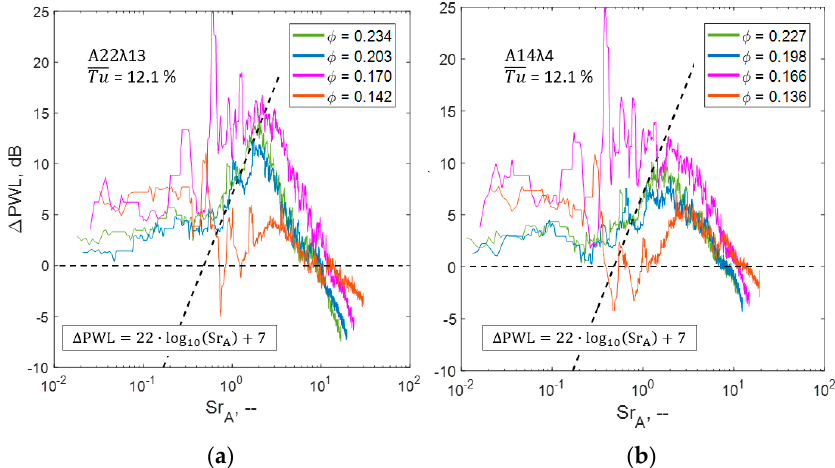
Figure 11. Spectral sound power level reduction Δ PWL at varying flow coefficient for two rotor designs ( a ) A22 λ 13; ( b ) A14 λ 4.